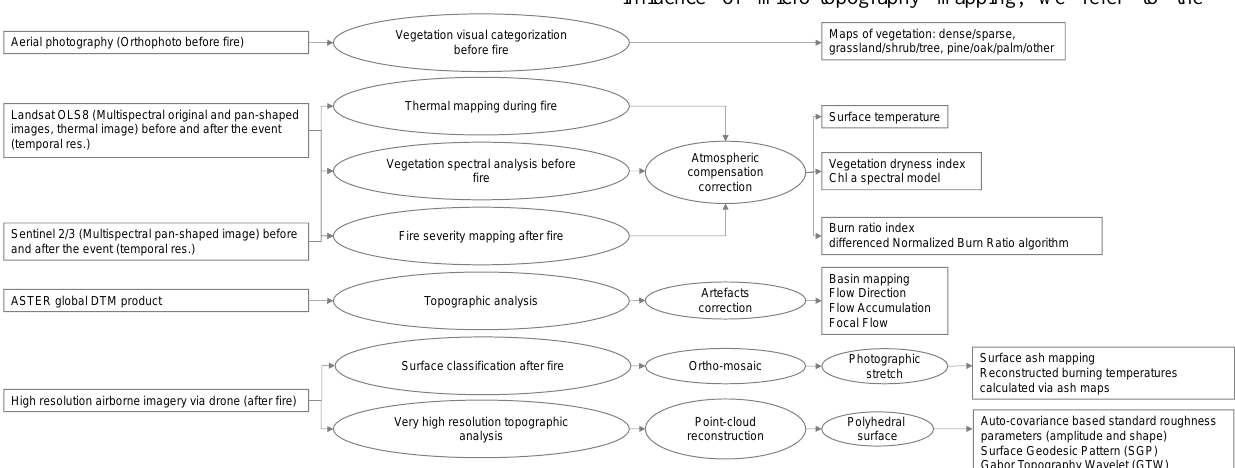
Figure 1. Flowchart of the multi-scale